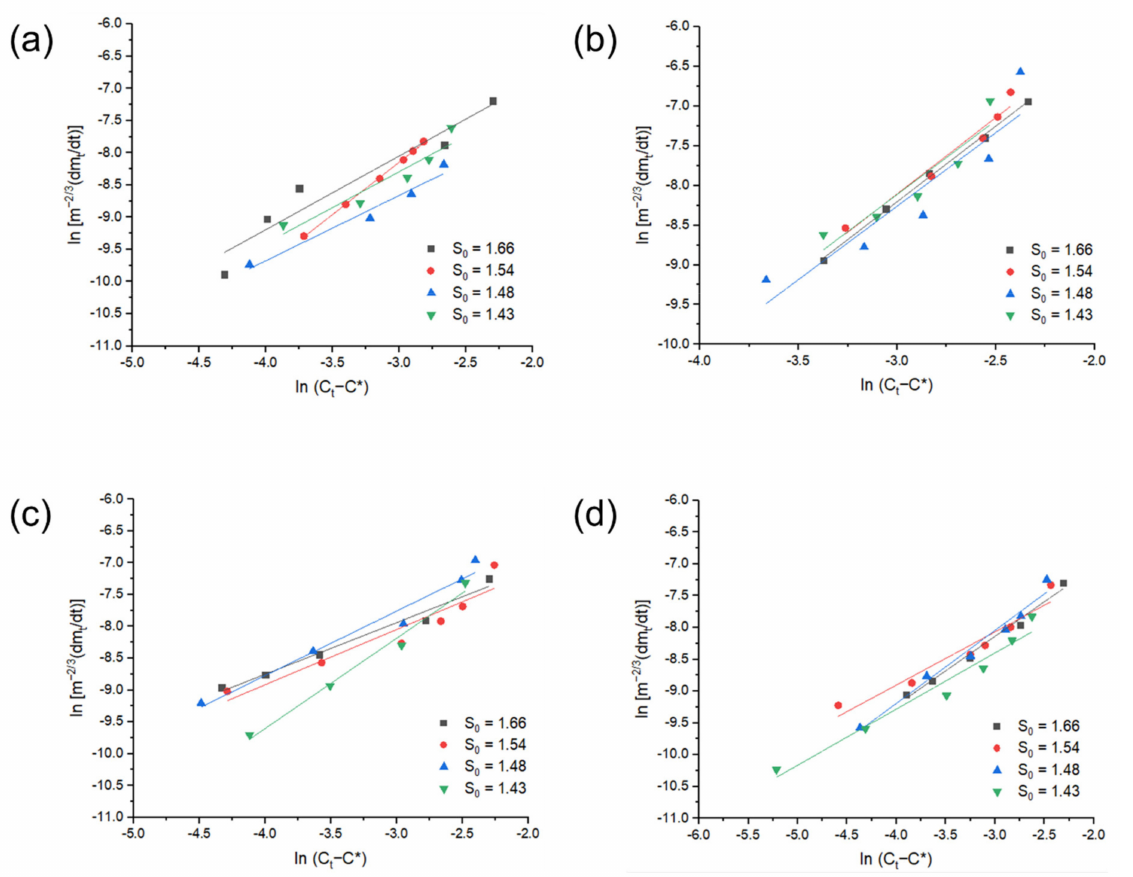
Figure 6. Plot of ln ( m − 2/3 ( dm t /dt )) vs. ln ( C t − C* ) of 2:1 HBz–NaBz co-crystallization by fitting to Equation (25): ( a ) without templating molecules, ( b ) with dissolved NaBz templating molecules, ( c ) with dissolved 2:1 HBz–NaBz co-crystal templating molecules, ( d ) with dissolved 1:1 HBz–NaBz co-crystal templating